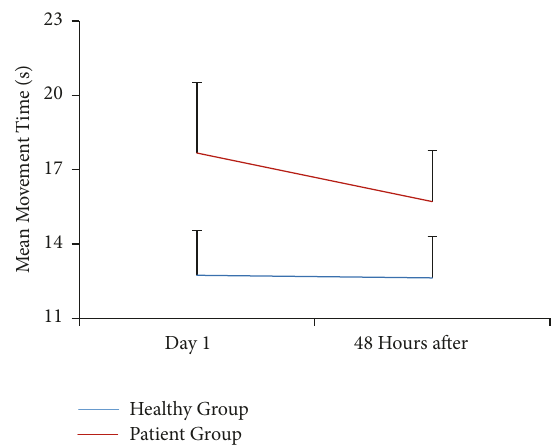
Figure 3: Mean and standard deviation movement time for the tapping task in the HG and the PG. Intra- and intergroup differences between Day 1 and 48 hours after treatment ( p < 0.05). Lines represent the means for each group.